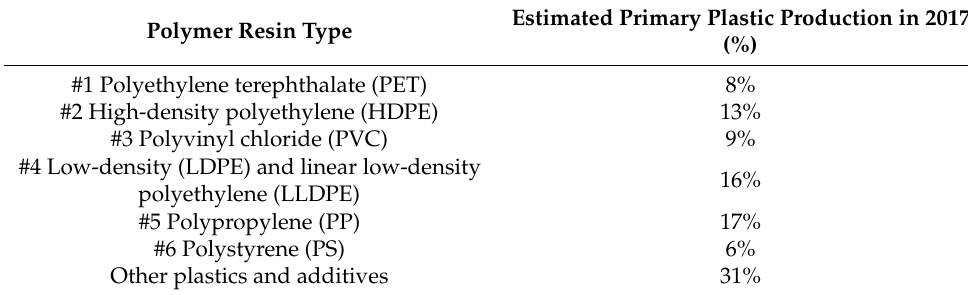
Table 1. Estimated primary plastic production in 2017 by resin type (by mass)